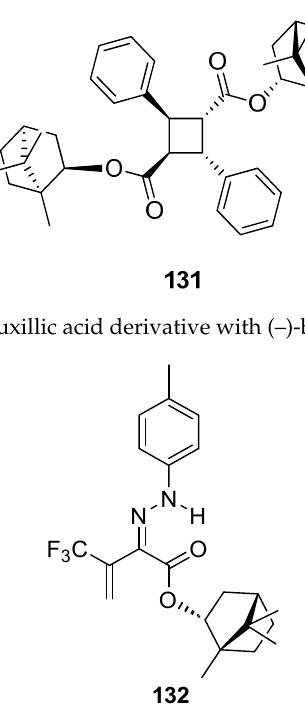
Figure 36. Ester derivative of natural occurring (–)-borneol with hydrazinylidene group.